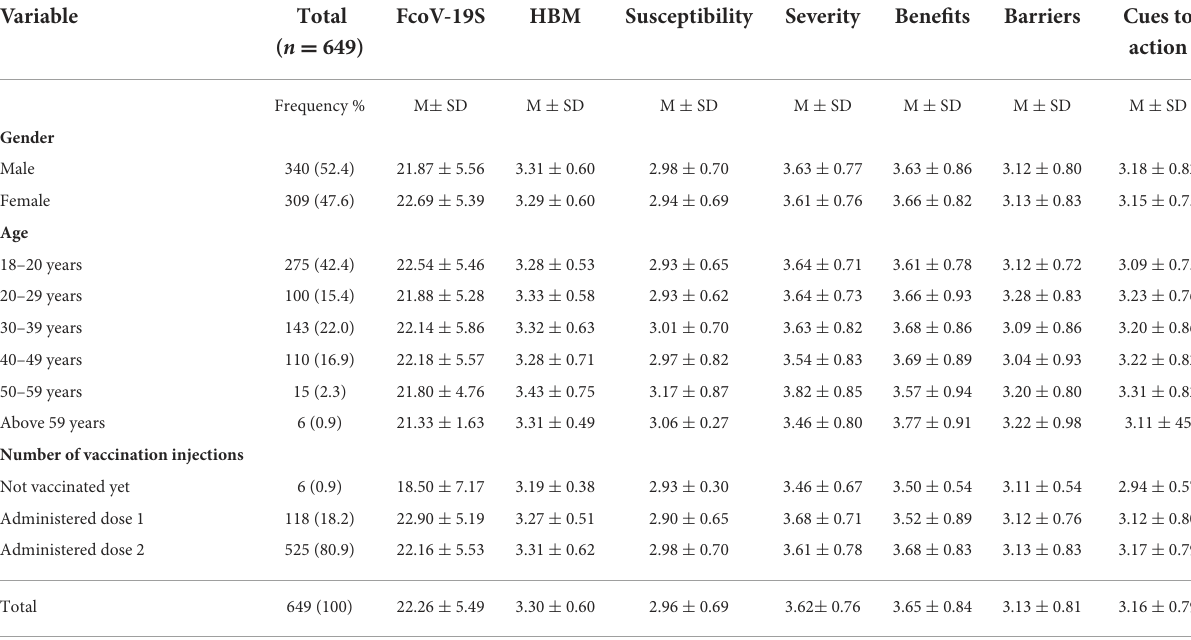
TABLE 1 Participants’ characteristics and scores on the fear of COVID-19 scale (FCoV-19S), and Health Belief Model scale (HBM). Variable Total FcoV-19S HBM Susceptibility Severity Benefits Barriers Cues to ( n = 649)